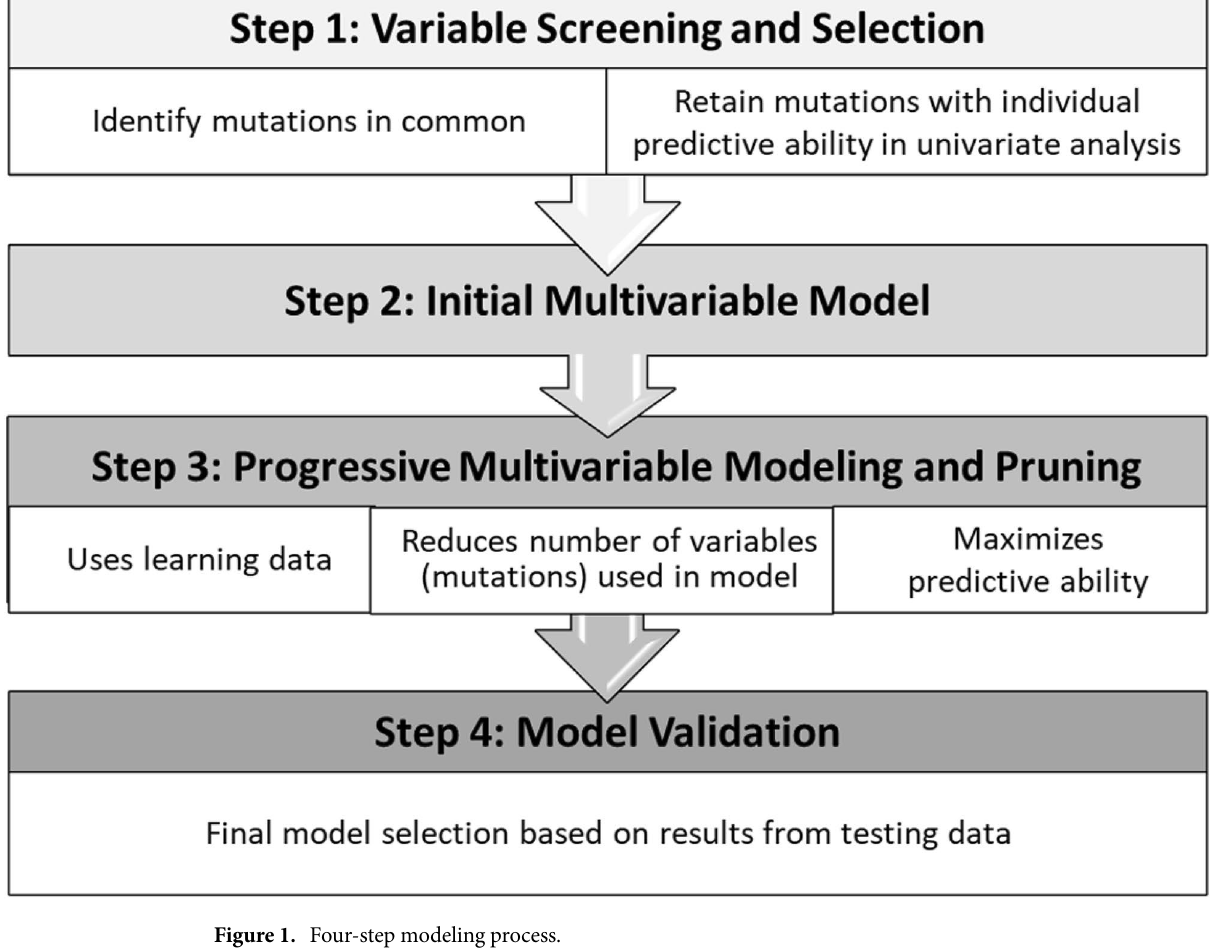
Figure 1. Four-step modeling